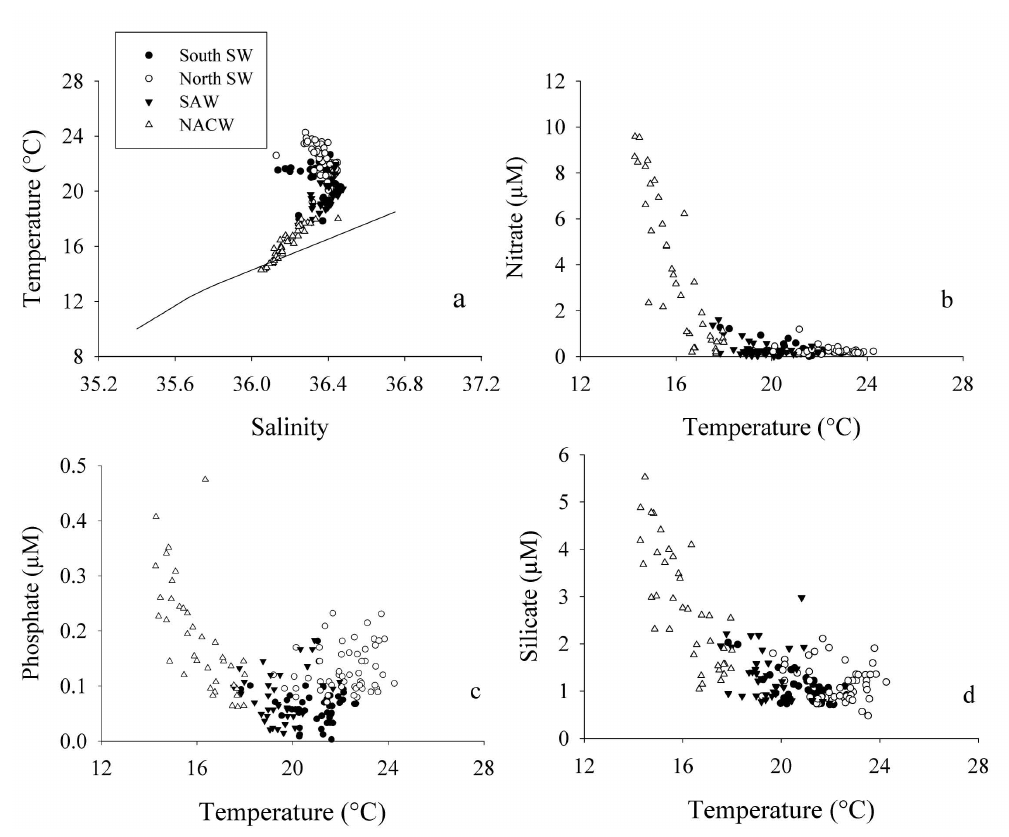
ig . 6. – Temperature-Salinity diagram (a) and relationship between temperature and nitrate (b), phosphate (c) and silicate (d) for all the col- lected samples during the Emigas I survey. NACW, SAW, South SW, North SW are the acronyms for North Atlantic Central Water, Surface Atlantic Water, North Surface Water and South Surface Water, respectively. NACW-TS refers line from Fiuza